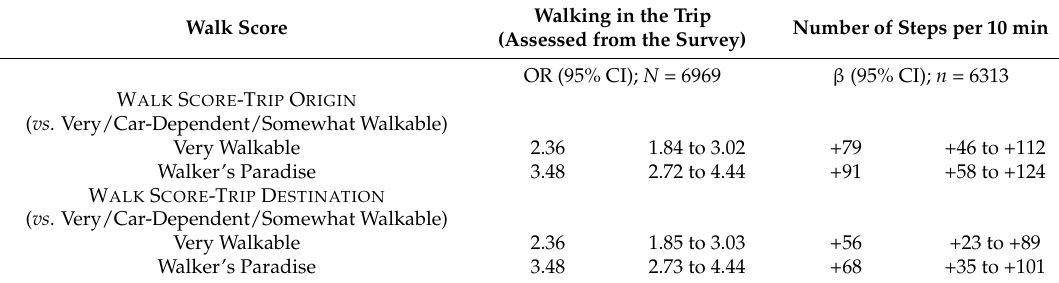
Table 3. Trip-level associations between categorical Walk Score and walking in a trip, from multilevel logistic and linear adjusted for individual/neighborhood